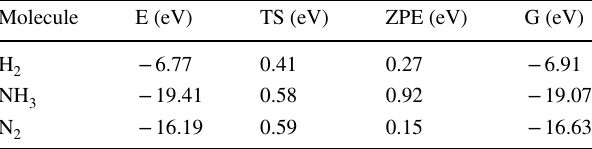
Table 1 The DFT energies, entropy terms and zero-point energies for free